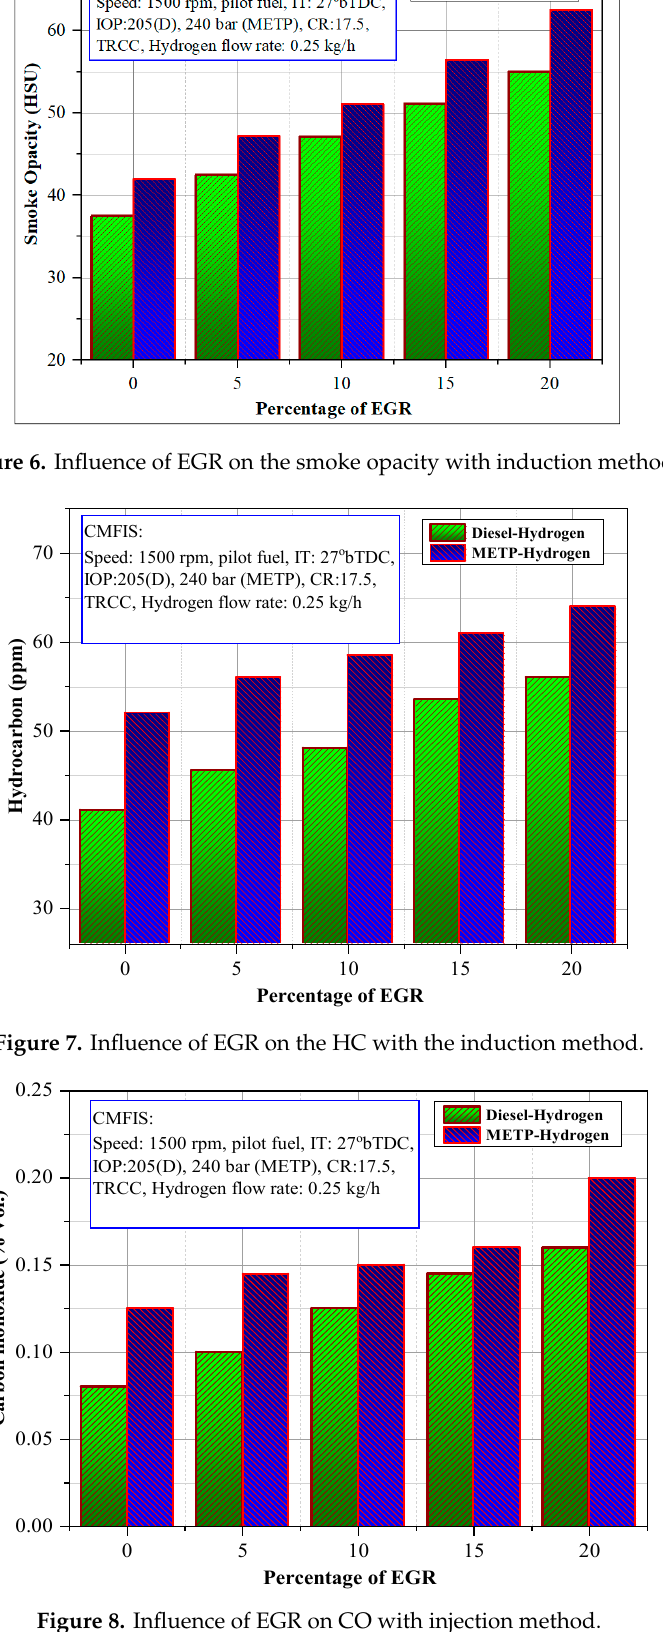
Figure 8. Influence of EGR on CO with injection method.